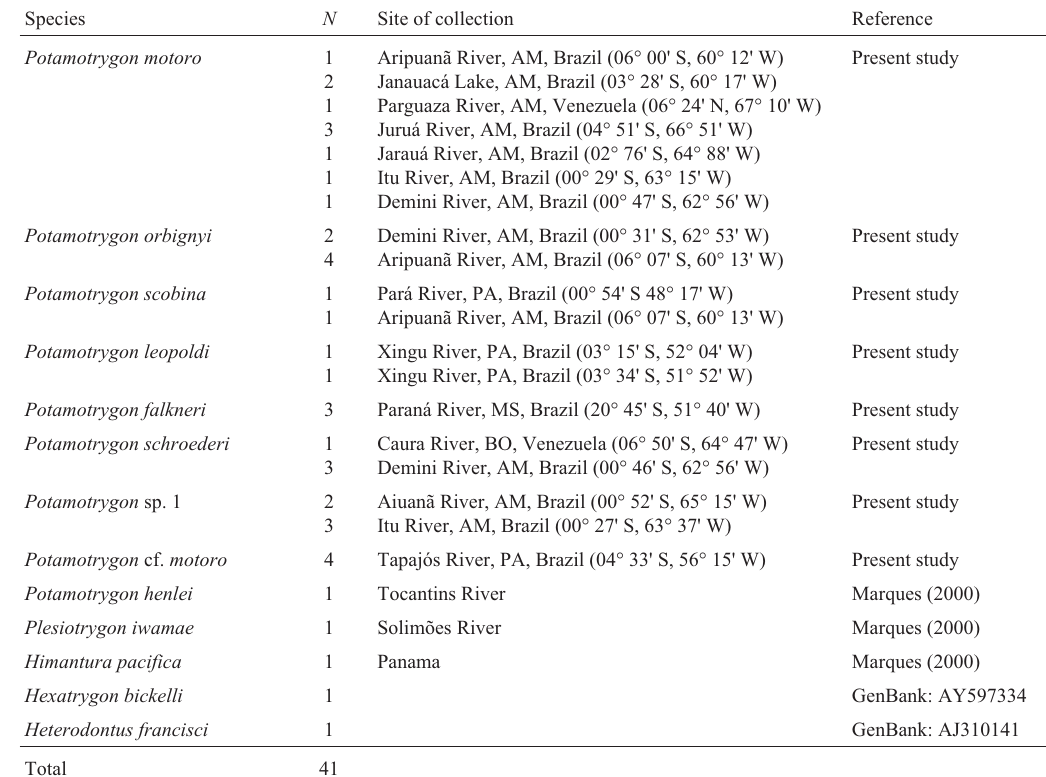
Table 1 - Analyzed species and localities of collection.